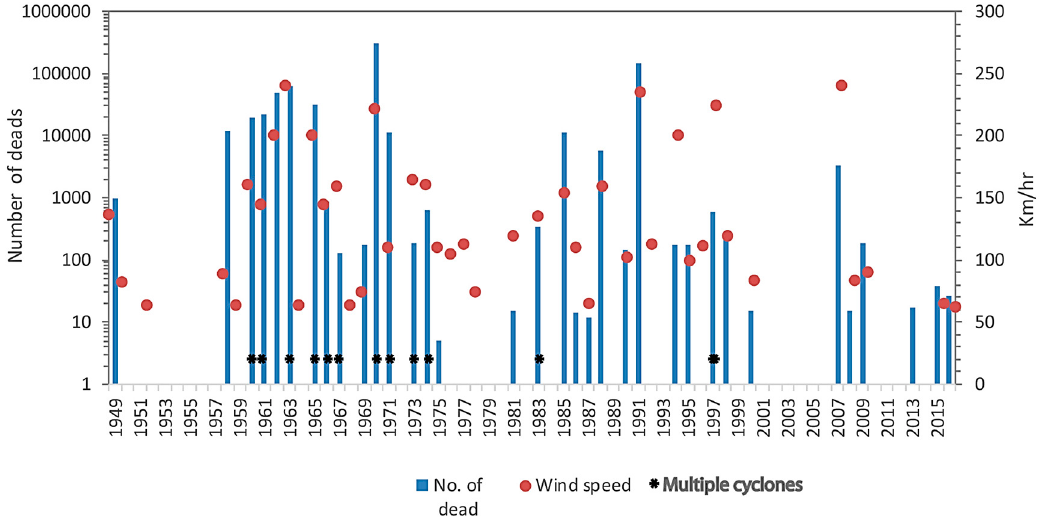
Figure 2. Historical cyclones and losses of lives (1948–2016). Wind speed is reported at the time of land fall of the cyclone. The data have been compiled from different sources such as Bangladesh Meteorological Department (BMD), published and unpublished papers, unclassified reports of the government and daily newspaper. In the case of conflicting information between sources, we relied on Government statistics. There were no data of human casualties or wind speed for several of the listed cyclones. Cyclone data that have missing information of both human casualties and wind speed have been excluded from the graph.